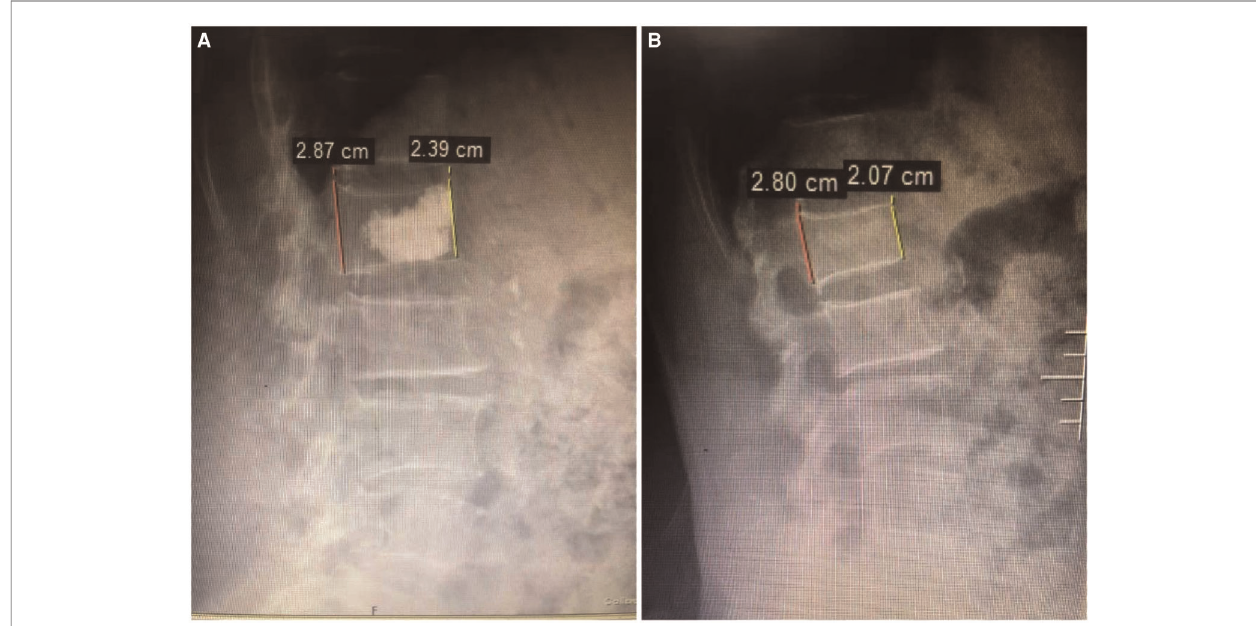
FIGURE 4 | Changes in the height of the anterior vertebral body detected by X-ray before ( A ) and after ( B ) PKP treatment.